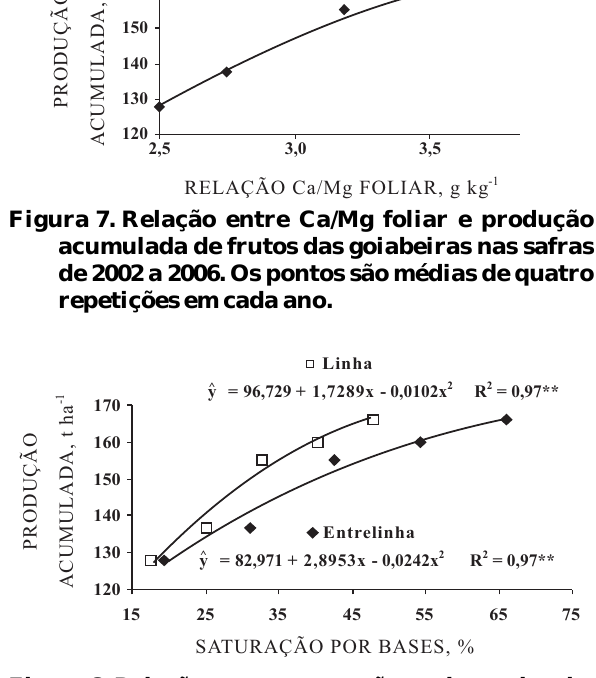
Figura 8. Relação entre a saturação por bases do solo, na camada de 0–20 cm, na entrelinha e na linha do pomar de goiabeiras (média de todas as amostragens) e a produção acumulada de frutos nos anos agrícolas de 2002 a